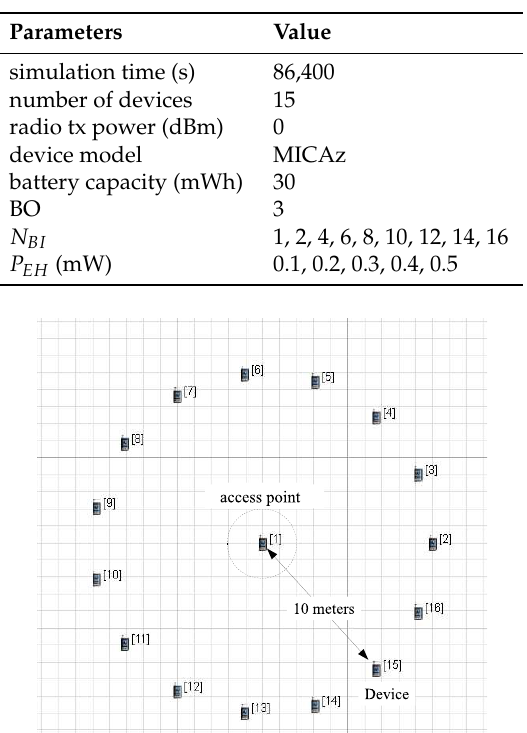
Table 2. Configuration of simulation parameters.